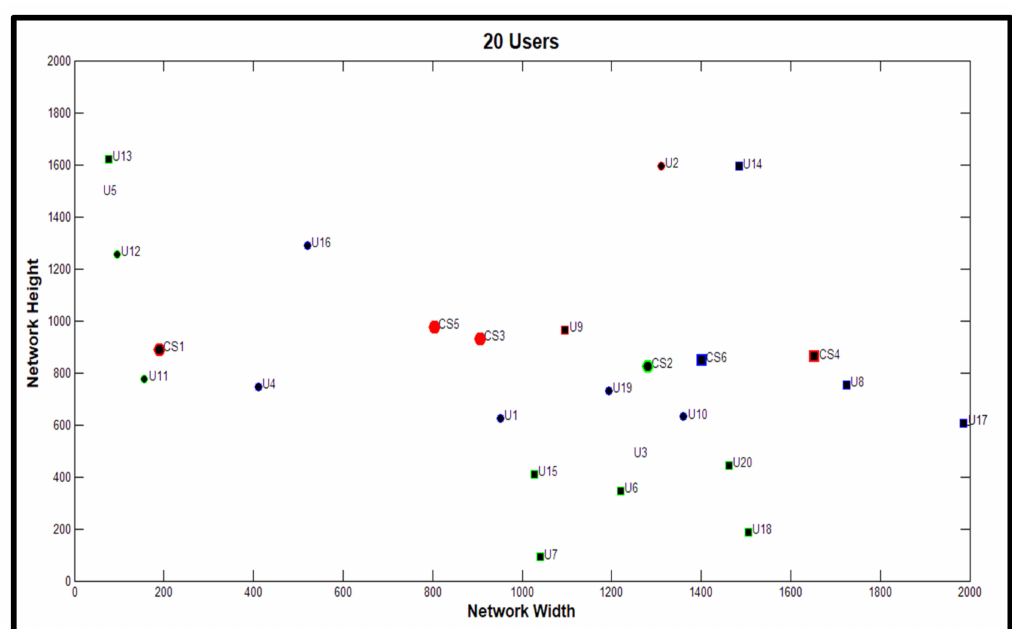
Figure 5. Resource